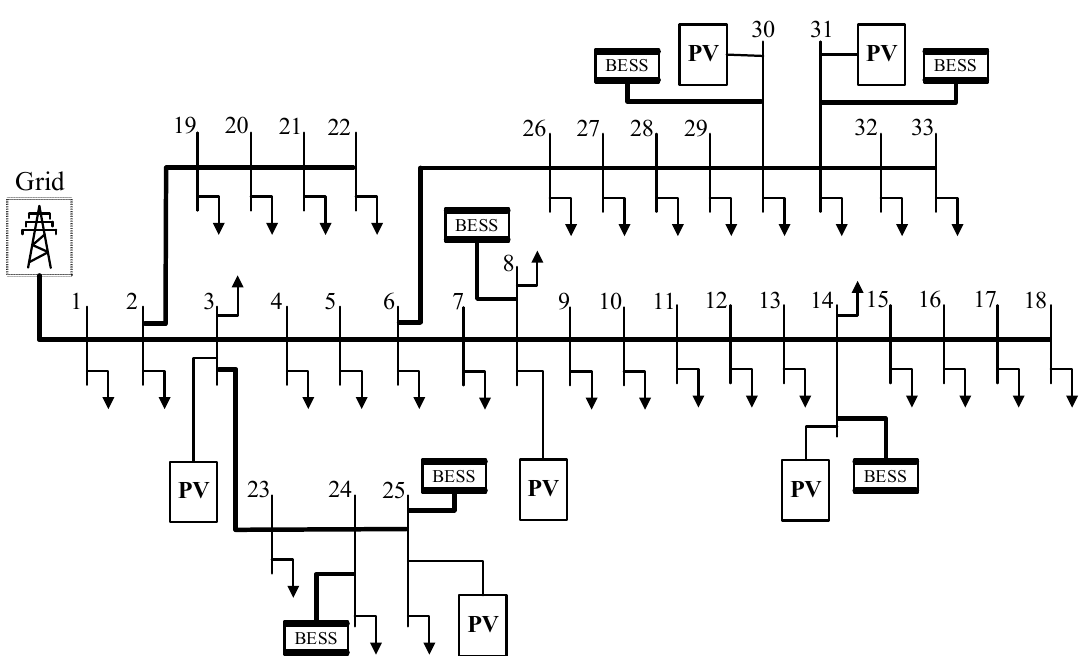
Figure 12. IEEE 33-Bus with PV and distributed BESS.